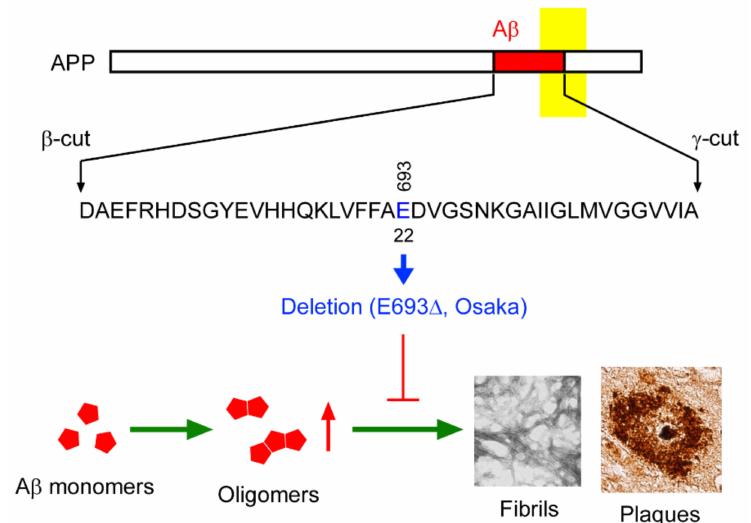
Figure 1. Identity of the Osaka mutation. The Osaka mutation is the deletion of codon 693 of APP gene that produces mutant A β lacking the 22nd glutamate. This mutation has a very unique character that accelerates A β oligomerization (red arrow) but does not form amyloid fibrils (T-shaped red line). Green arrows indicate A β aggregation